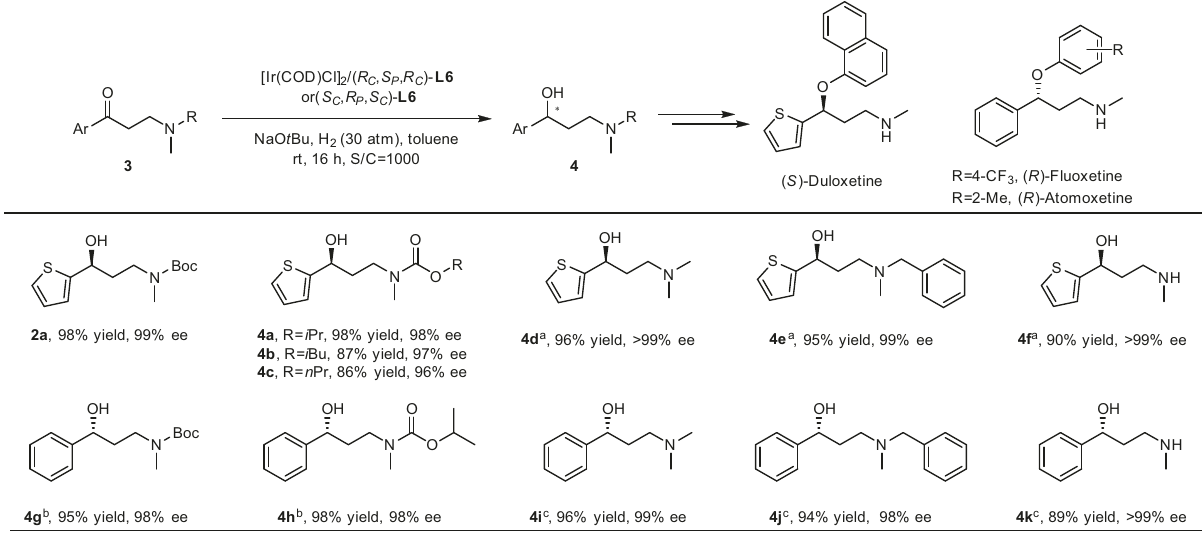
Fig. 3 Asymmetric synthesis of chiral intermediates of (S)-duloxetine, (R)- fl uoxetine, and (R)-atomoxetine. Reaction conditions: 0.4 mmol scale, 0.05 mol% [Ir(COD)Cl] 2 , 0.105 mol% ( R C , S P , R C )- L6 , 5 mol% NaO t Bu, 2.0 mL toluene, room temperature (25 – 30 °C). Isolated yields. The ee